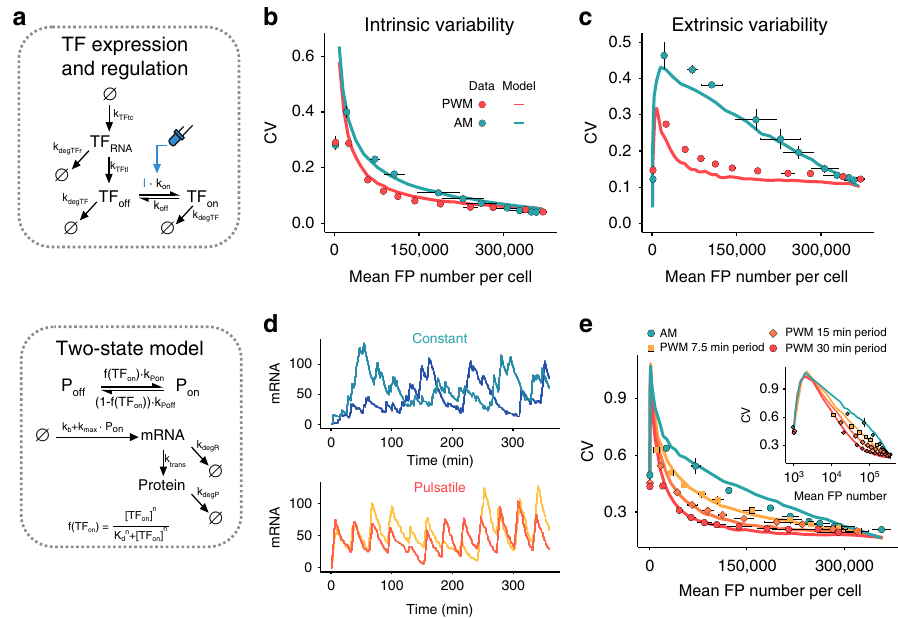
Fig. 4 A stochastic model of VP-EL222 mediated gene expression. a Graphical representation of the stochastic model describing VP-EL222/TF expression and activation (top) and VP-EL222/TF mediated reporter gene expression (bottom). The light input is denoted by I. Arrows depict reactions. Details on the modeling approach can be found in Supplementary Note 4. b and c Modeling results (lines) and experimental data (circles) showing intrinsic ( b ) and extrinsic ( c ) contributions to gene expression variability (see Supplementary Table 6 for model parameters). A dual-color reporter experiment was simulated for 6 h and the variability decomposition procedure was applied to the simulated data as described in Methods section for the experimental data. Experimental results are the same as shown in Fig. 3b, c. d Intrinsic mRNA expression dynamics under constant (top, simulated intensity of 140 µ W cm − 2 ) and pulsatile regulation (bottom, simulated PWM period of 30 min with 20% duty cycle and 420 µ W cm − 2 light intensity). Simulations were performed without the incorporation of extrinsic variability, meaning with fi xed levels of VP-EL222 expression (24,600 proteins per cell). Two single-cell traces are shown per condition. e Model predictions for the single 5xBS- CYC180 pr reporter strain under different AM and PWM conditions. Data are the same as shown in Fig. 3a (see Supplementary Table 6 for model parameters)